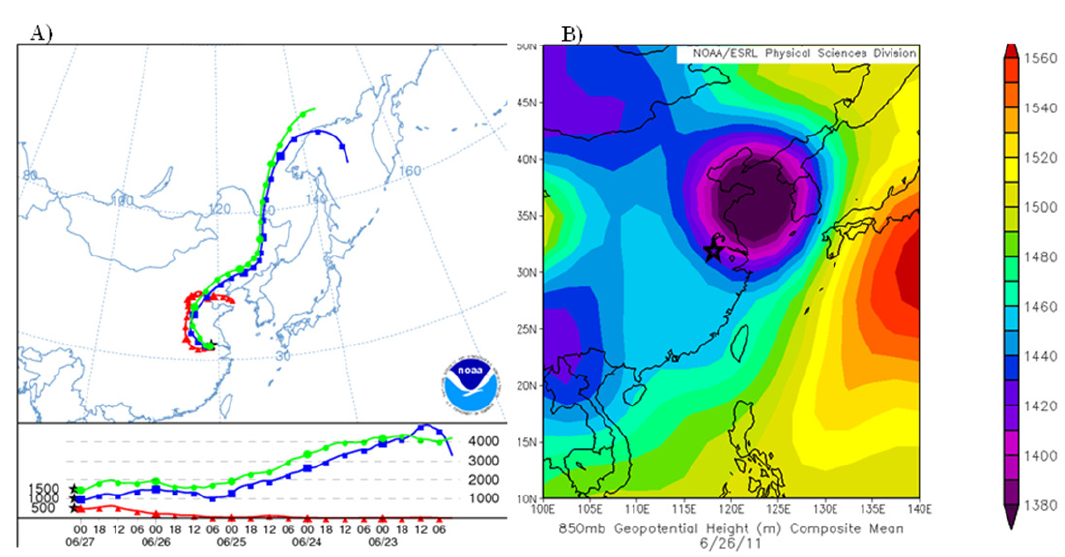
Figure 13. ( A ) Five-day backwards trajectory from Nanjing ending on 27 June 2011, at 02:00 UT. ( B ) NCEP/NCAR reanalysis at 850 hPa showing low-pressure system that passed over Nanjing on 26 June 2011 and imported high mercury on 27 June